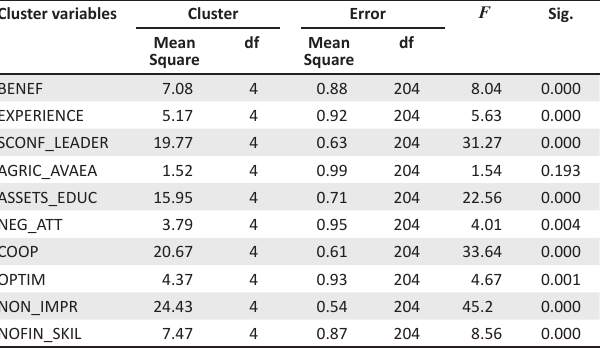
TABLE 1-A1: ANOVA table from the K -Means Cluster